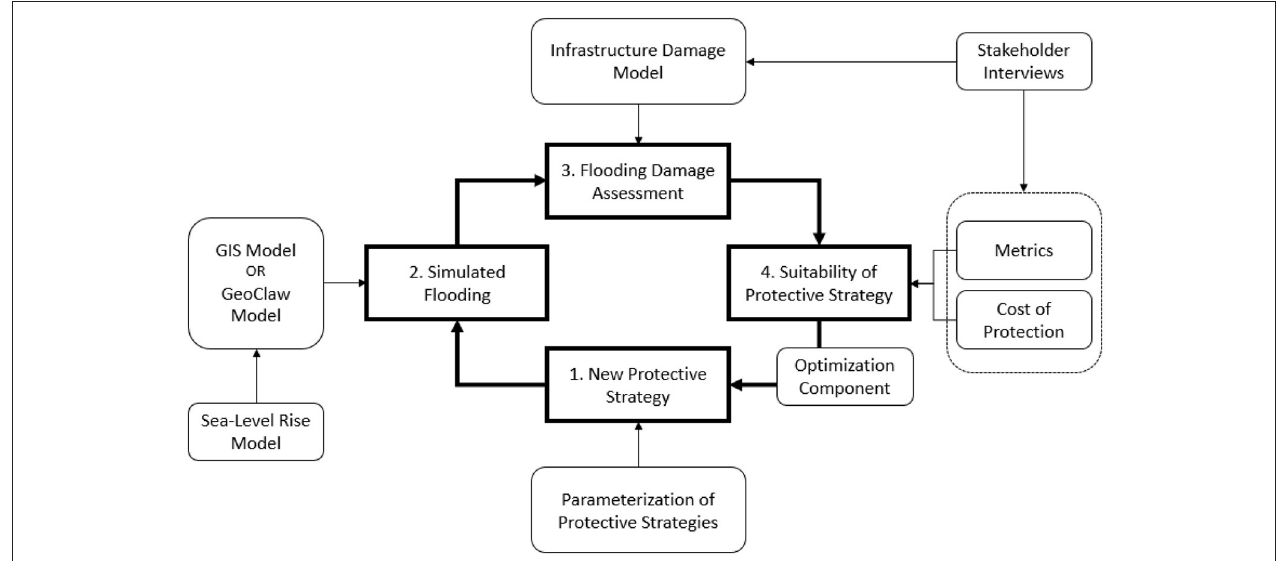
FIGURE 1 | Conceptual layout of the proposed methodological framework (Miura et al., 2021c).